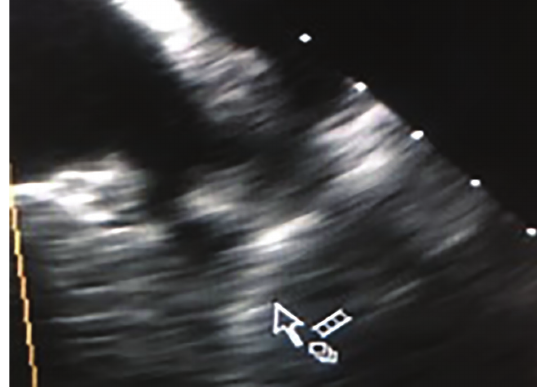
Figure 2B - LAA thrombus confirmed by TEE in the same patient